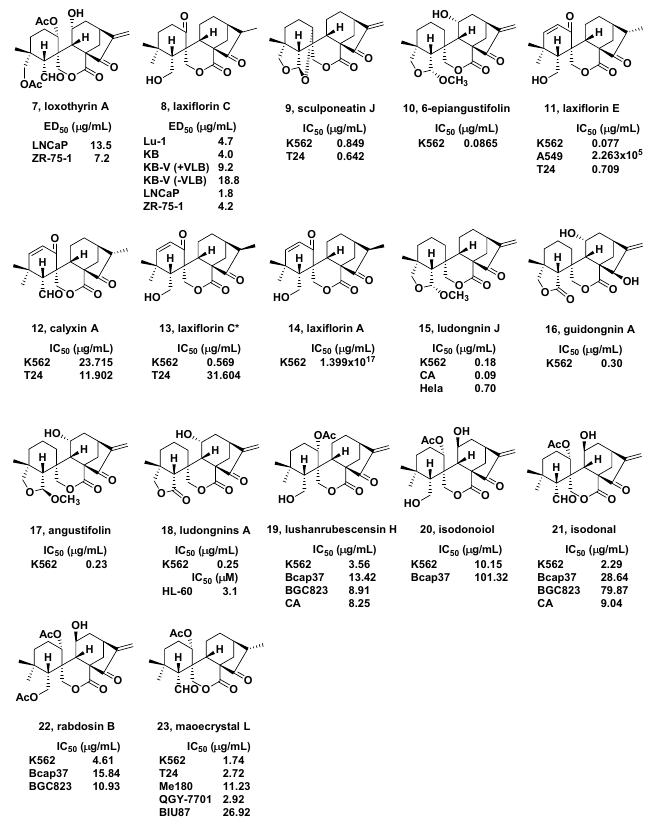
Figure 2. Bioactive natural spirolactone-type diterpenoids 7 – 23 .